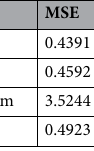
Table 6. The MSE means of the comparative methods.